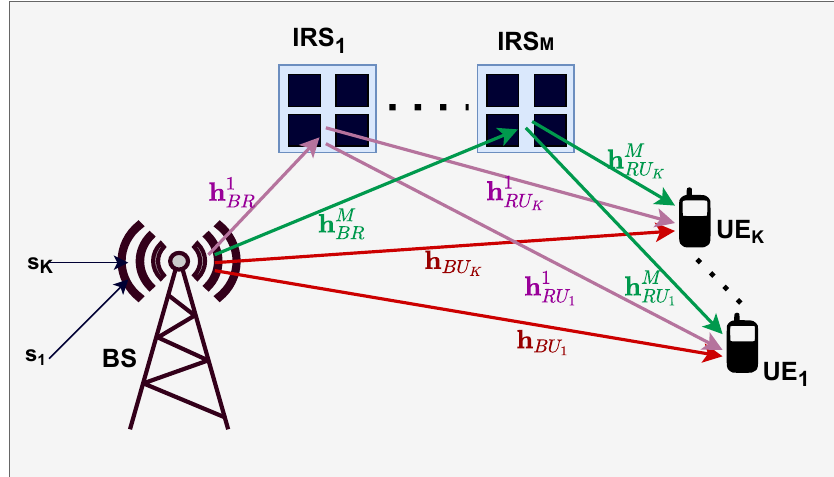
Figure 10. IRS-assisted Downlink Communication System: Multi-IRS and